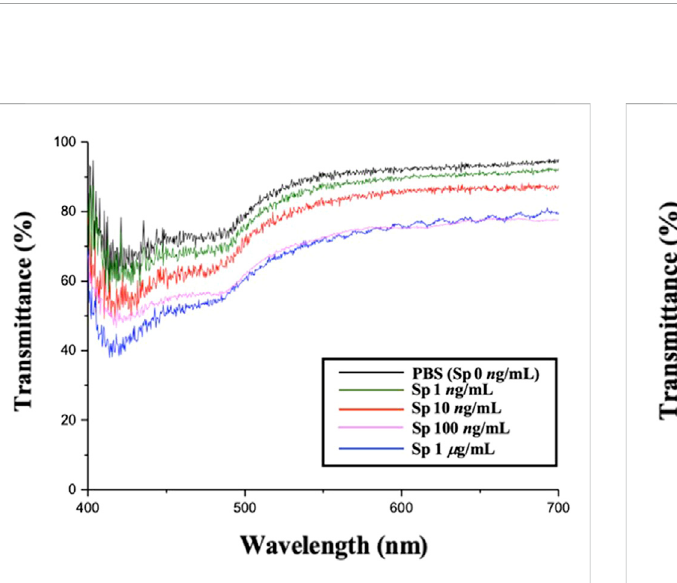
FIGURE 6 Penetration spectra of different concentrations of the spike protein detected on cholesterol liquid crystal chips.